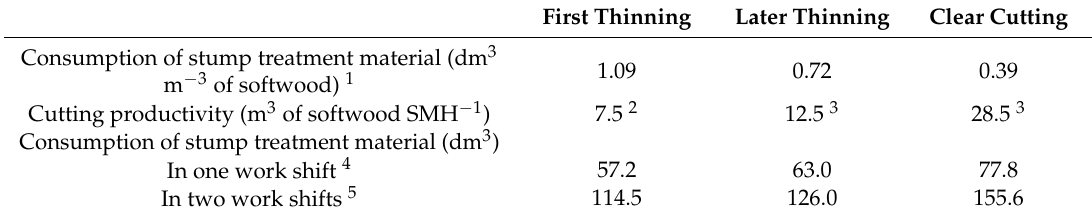
Table 6. Calculation of the sufficient volumes of storage tanks for the stump treatment material in harvesters working in one and double work shifts by cutting method. First Thinning Later Thinning Clear Cutting Consumption of stump treatment material (dm 3 m − 3 of softwood)